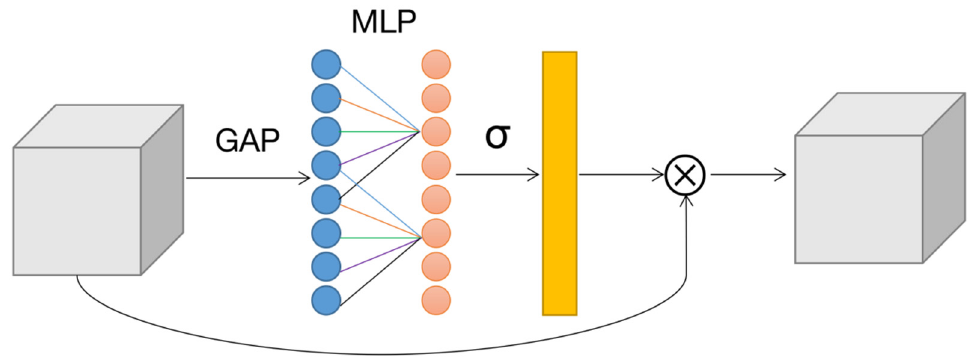
Figure 9. Efficient channel attention networks structure.